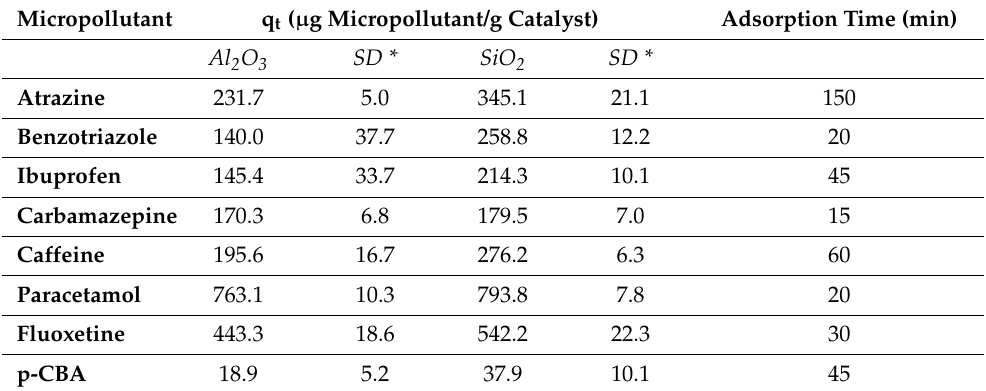
Table 3. Adsorption capacity of Al 2 O 3 and SiO 2 materials for the examined micropollutants, present- ing different physicochemical properties. Experimental conditions: C micr. 500 µ g/L, C cat. 0.5 g/L,